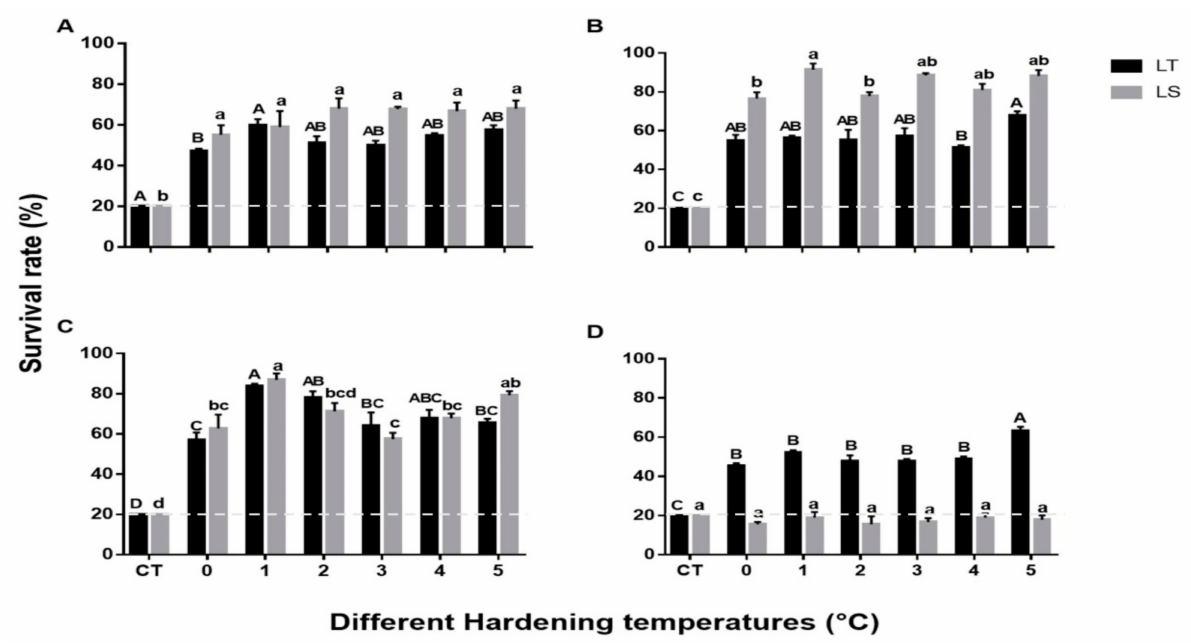
Figure 2. Mean survival of pupae and adults of L. trifolii and L. sativae at different hardening temperatures. Pupae and adults were exposed to 0, 1, 2, 3, 4, and 5 ◦ C for 4 h and then transferred to the critical temperature for each life stage (shown in caption of Figure 1) for 2 h. Survival was examined after pupal emergence while adult survival was checked after a 20 min recovery period. Different letters indicate significant differences; lowercase and uppercase letters were used for L. sativae and L. trifolii , respectively. Abbreviations: LT, L. trifolii ; LS, L. sativae ; and CT, critical temperature.